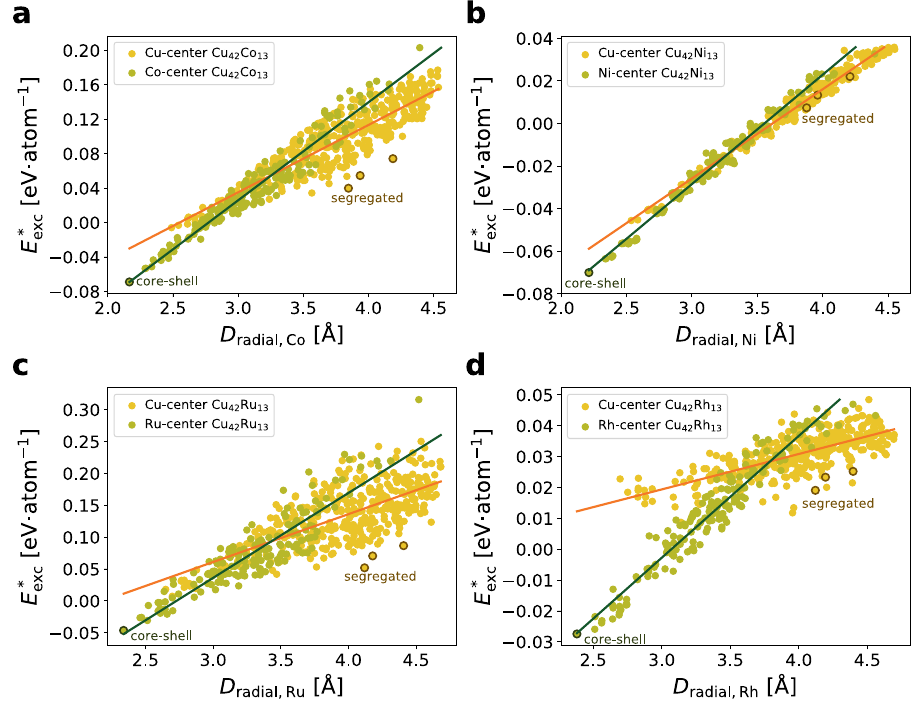
Fig. 3 Energies and structural patterns for Cu 42 M 13 clusters. The excess energies ( E (cid:3) Cu 42 Rh 13 alloy clusters as a function of the average radial distance ( D radial, M ) between the dopant metal atoms and the central atom. The core – shell structure and the segregated structure are illustrated.